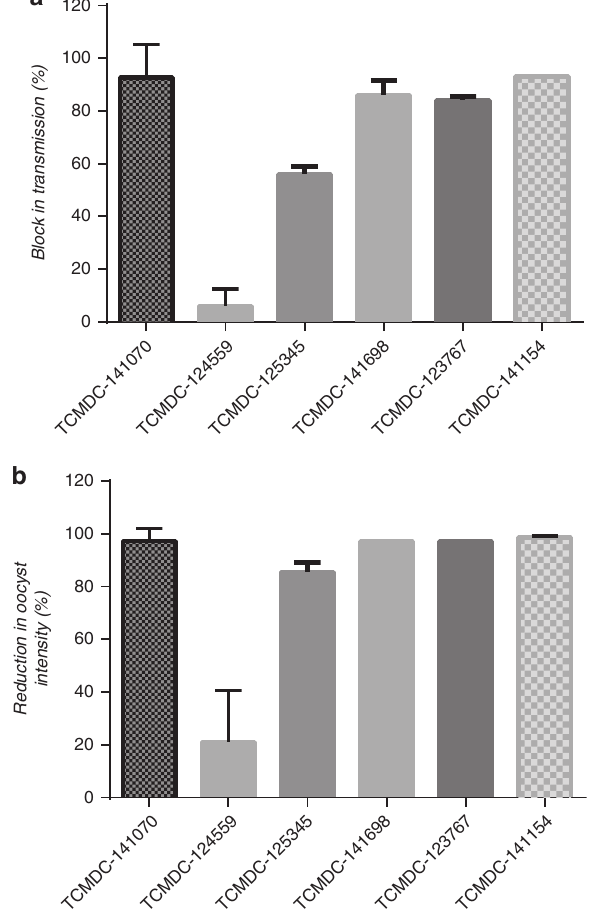
Figure 6 | Effect of selected TCAMS compounds in the SMFA. The following parameters were measured: ( a ) Transmission-blocking activity (prevalence reduction) and ( b ) reduction in mean P. falciparum oocyst intensity. Each bar represents mean value of two (TCMDC-125345, TCMDC-141698, TCMDC-123767, TCMDC-141154) or three (TCMDC- 141070, TCMDC-124559) independent replicates with